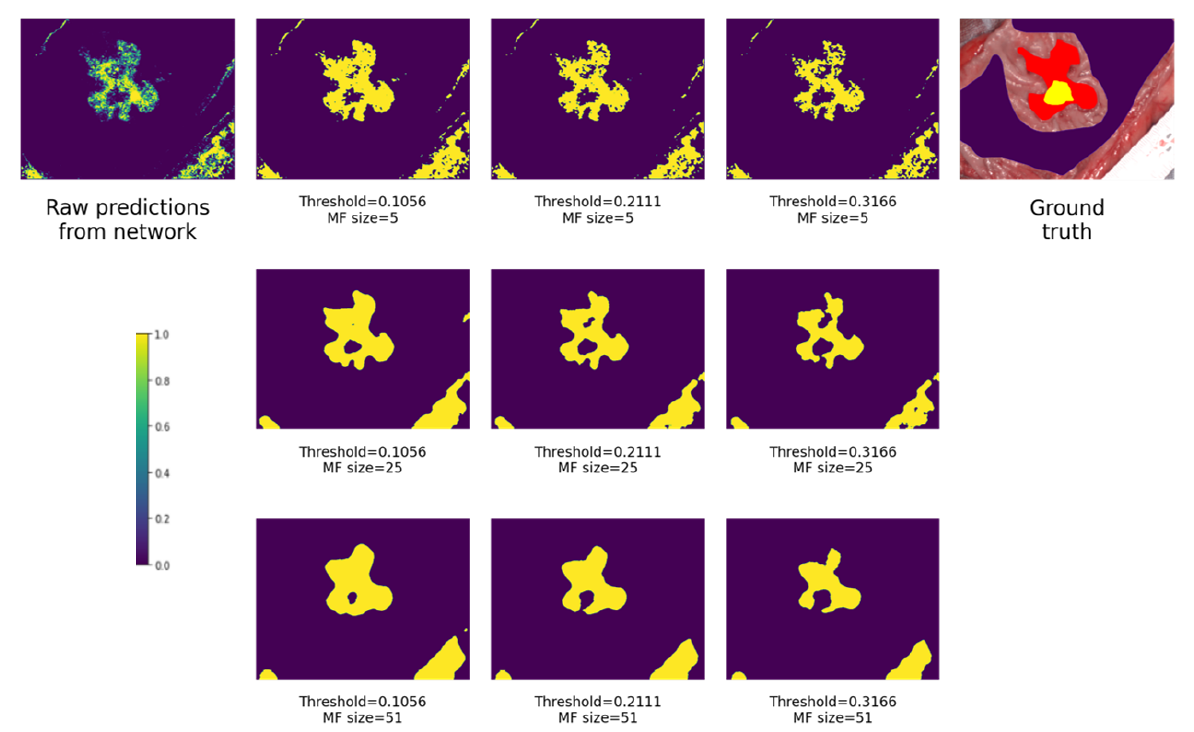
Figure 14. How different MF sizes and thresholds affect the output. Purple is non-malignant tissue, yellow is cancerous, red is cancerous margin, and shades of green are uncertain.